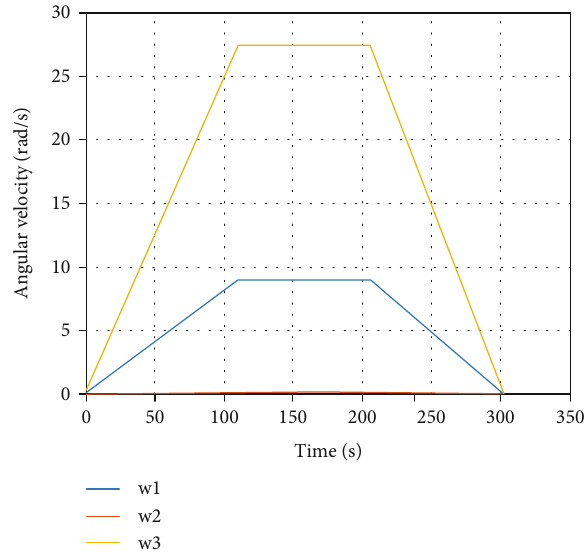
Figure 10: Angular velocity time history based on the grey wolf optimizer.